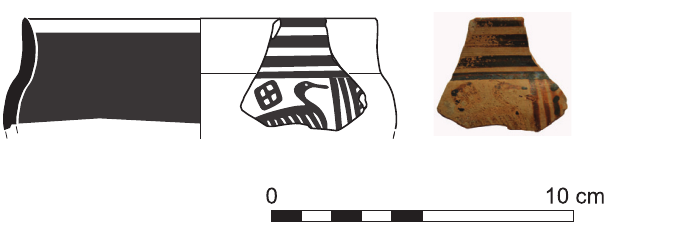
Fig 32. Fragment of Euboean bird skyphos from Sidon phase K dating to Late Geometric I.